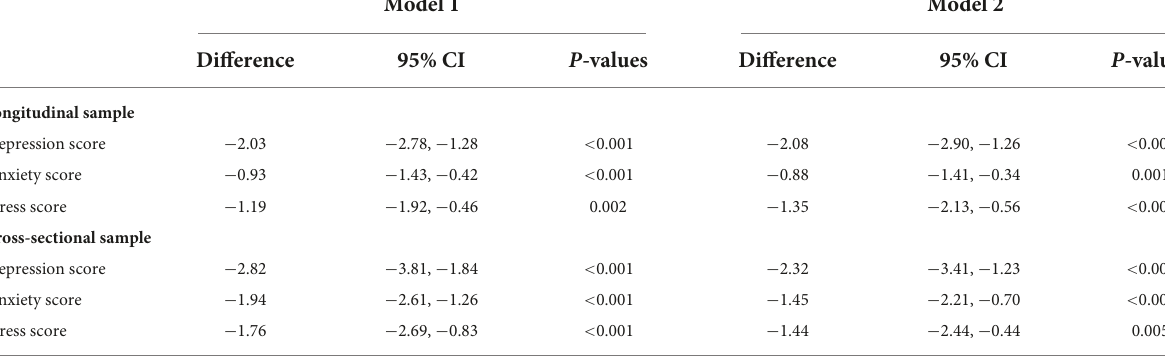
TABLE 5 Associations between mental health scores and meeting physical activity